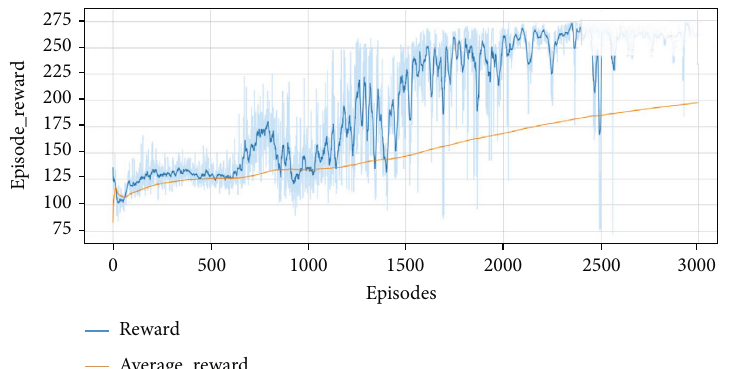
Figure 7: TD error change.